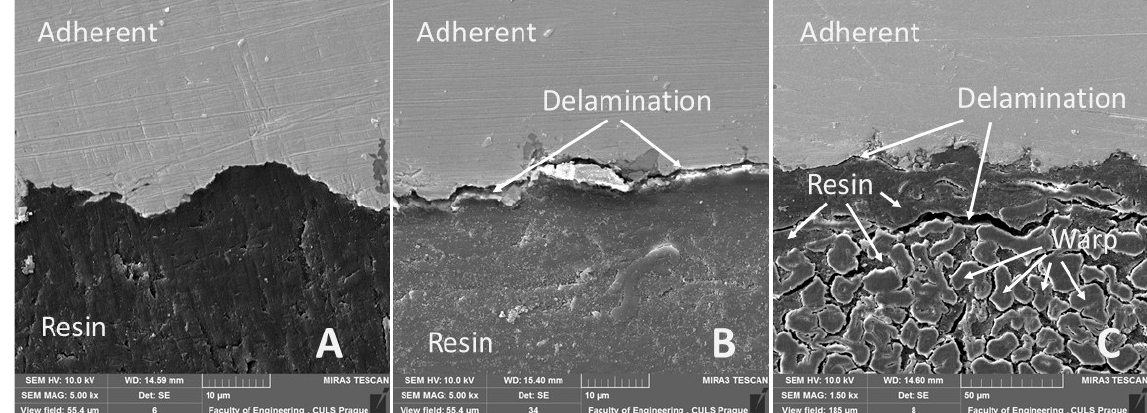
Figure 13. SEM images of cross-section of tested adhesive bond: ( A ): cross-section of Resin-Flat (MAG 5000×), ( B ): cross-section of Erik-WH1, 1000 cycles in interval 5–50% (267–2674 N) (MAG 5000×), ( C ): cross-section of Tera-Flat, 1000 cycles in interval 5–70% (267–3743 N) (MAG 5000×).